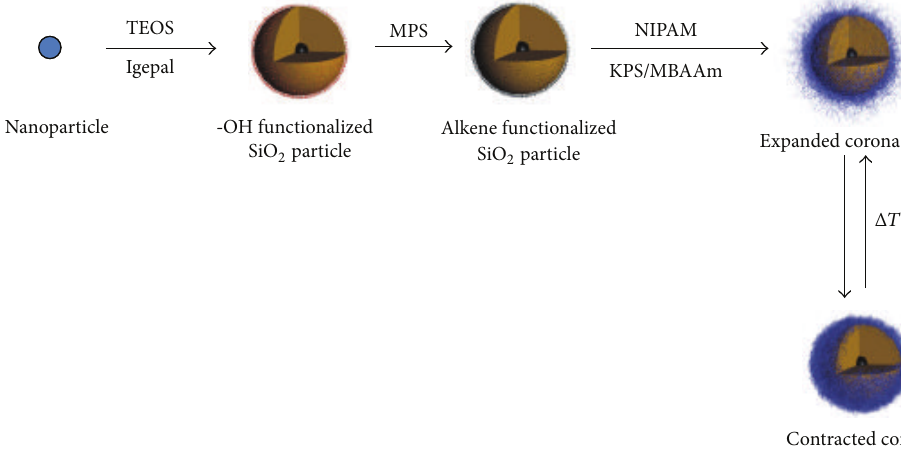
property can be either controlled by the particle size of SiO 2 or the